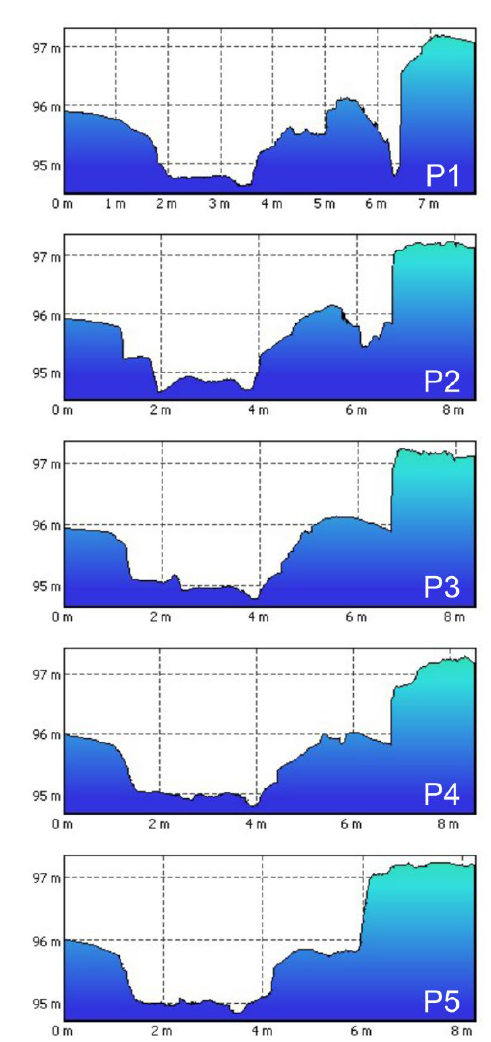
Figure 5. The profiles of the Sette Metri aqueduct. Refer to figure 4 for the profile lines.